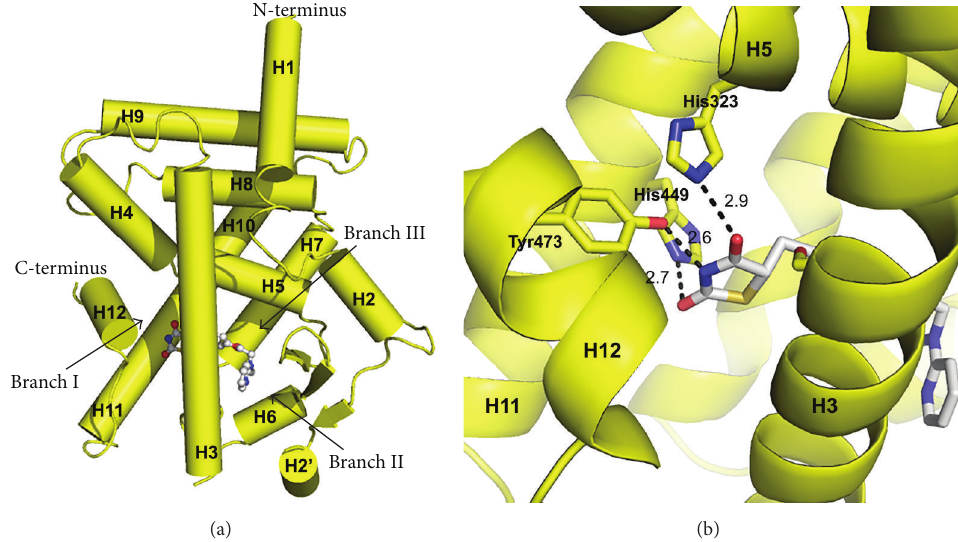
Figure 2: Interaction mode of full agonist rosiglitazone. The PPAR 𝛾 ligand binding domain is shown in yellow and rosiglitazone is shown in white sticks coloured by element. (a) Ribbons diagram of the PPAR 𝛾 ligand binding domain bound to rosiglitazone. The branches of the ligand binding pocket have been labelled with Roman numerals. (b) Hydrogen bond network of the rosiglitazone TZD head group with AF2 residues. PDB: 4EMA